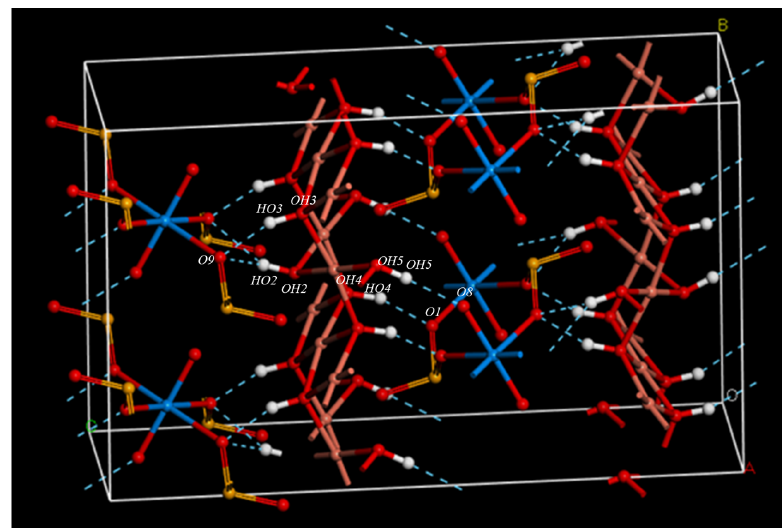
Figure 8. Hydrogen bonding structure in the crystal structure of derriksite.